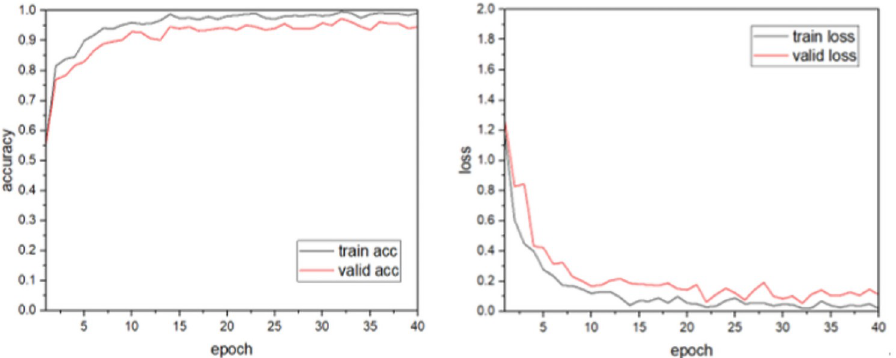
Fig 8. Accuracy of the model trained on the system with the